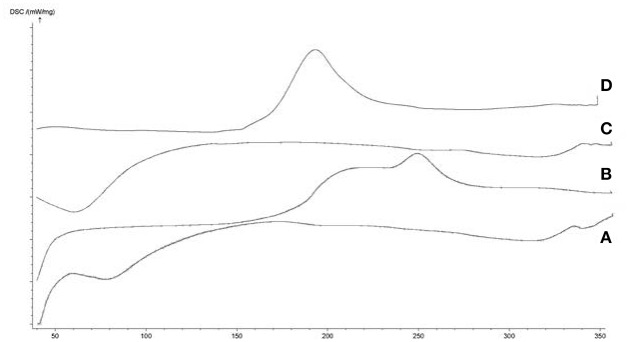
DSC curves of (A) BCP, (B) HPβCD, (C) physical mixture, and (D) HPβCD/BCP. BCP generated a wide exothermic peak from 180 to 260°C. HPβCD exhibited an endothermic peak at 60°C. An exothermic peak of physical mixture appeared at 190°C. An endothermic peak of HPβCD/BCP appeared at 70°C, but no peak showed up from 180 to 260°C.